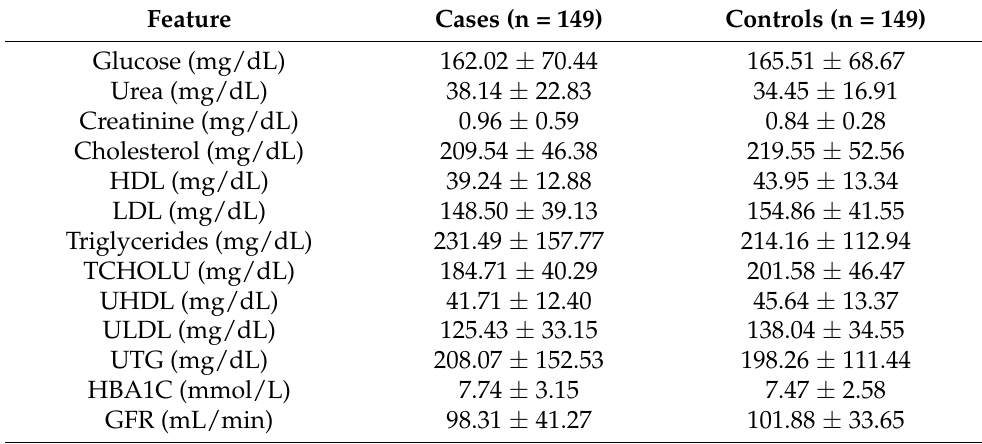
Table 3. Biochemical indicators of all the subjects included.